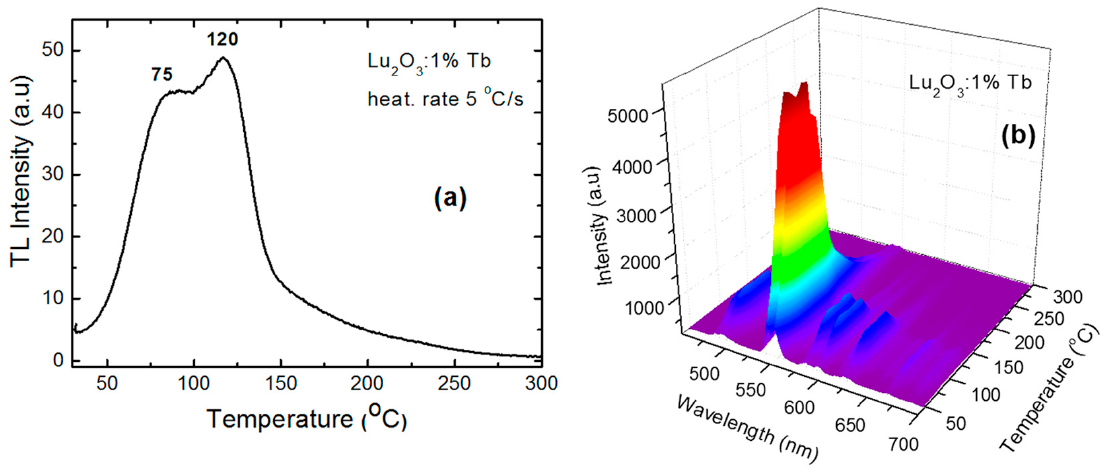
Figure 10. Glow curve ( a ) and TSL spectra ( b ) of Lu 2 O 3 :Tb NPs after irradiation with X-rays at 300 K.